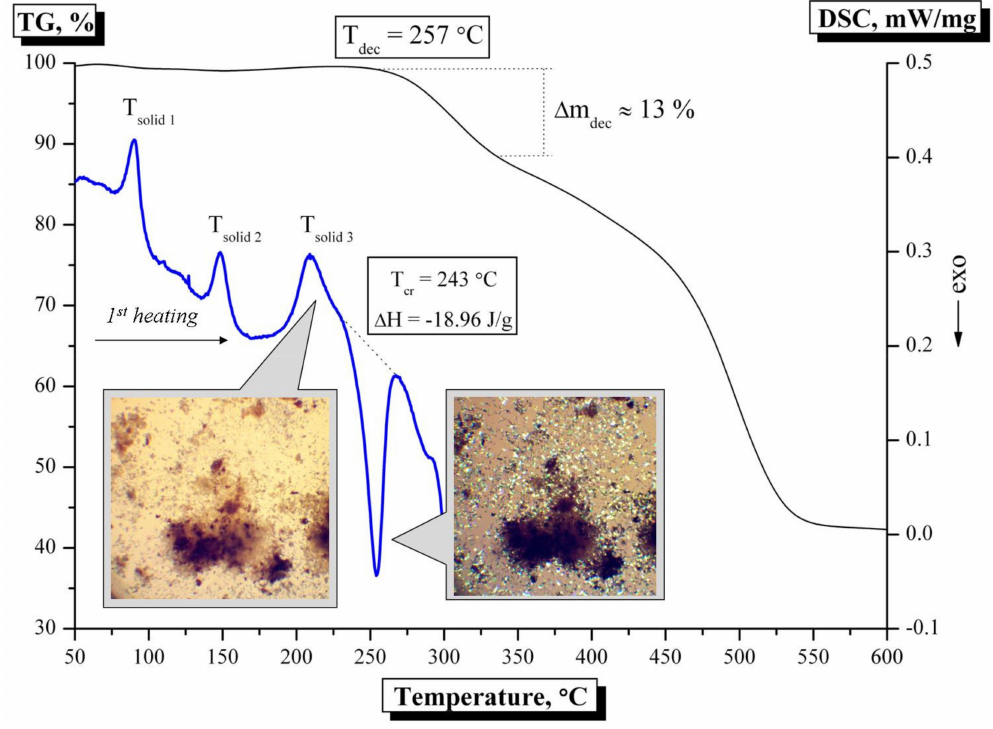
Figure 1. TG and DSC curves (heating cycle), and photographs of complex 3